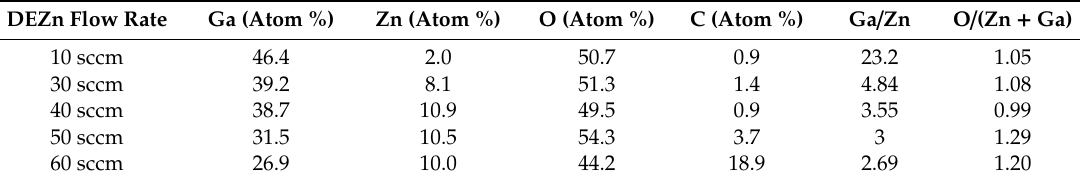
Table 6. Elemental compositions (Ga, Zn, O, and C), the ratios of Ga / Zn and O / (Zn + Ga) for ZnGa 2 O